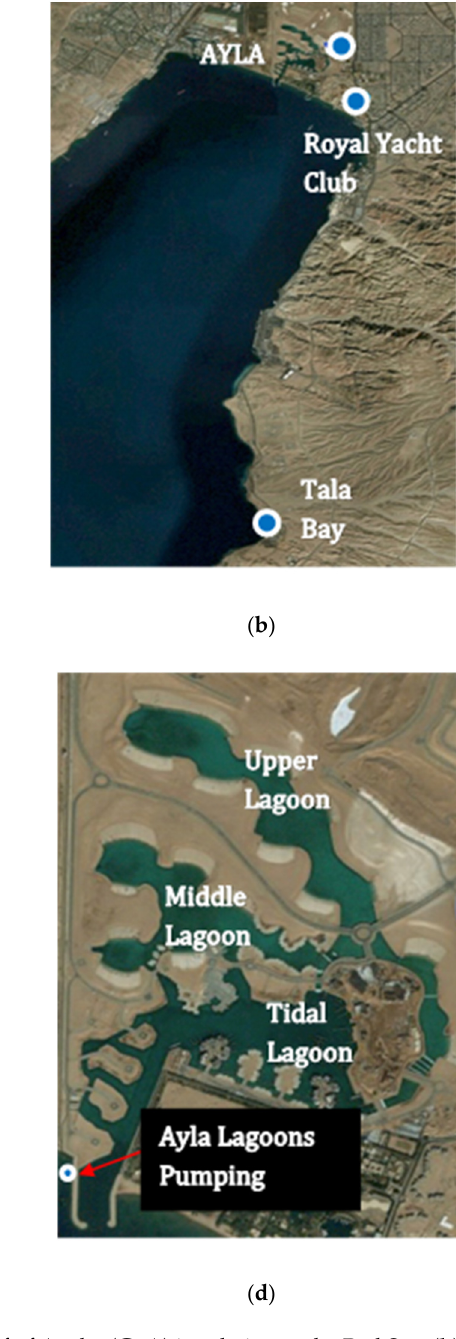
Figure 1. Maps showing: ( a ) the location of the Gulf of Aqaba (GoA) in relation to the Red Sea; ( b ) the locations for Ayla, Royal Yacht Club, and Tala Bay in relation to the GoA; ( c ) Ayla lagoons before pumping in the water, showing the sea frontage of 235 m; ( d ) Ayla lagoons after they were filled with seawater pumped from the GoA in May 2012.